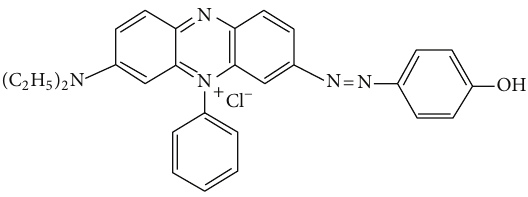
Scheme 1: Structural formulae of Astrazon Black